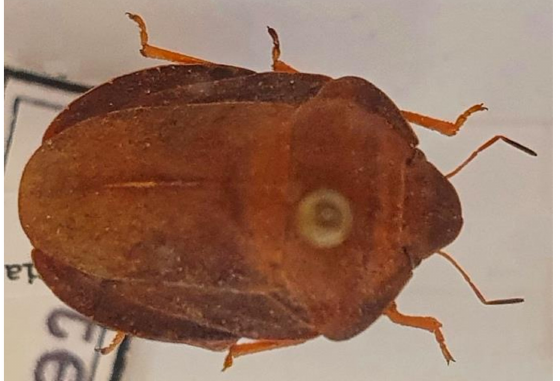
Figure 21. Eurygaster hottentotta (Collector S. Drosopoulos, Kastanitsa, 20.VII.1982, posited in S. Drosopoulos historical collection. Photo A. Tsagkarakis,